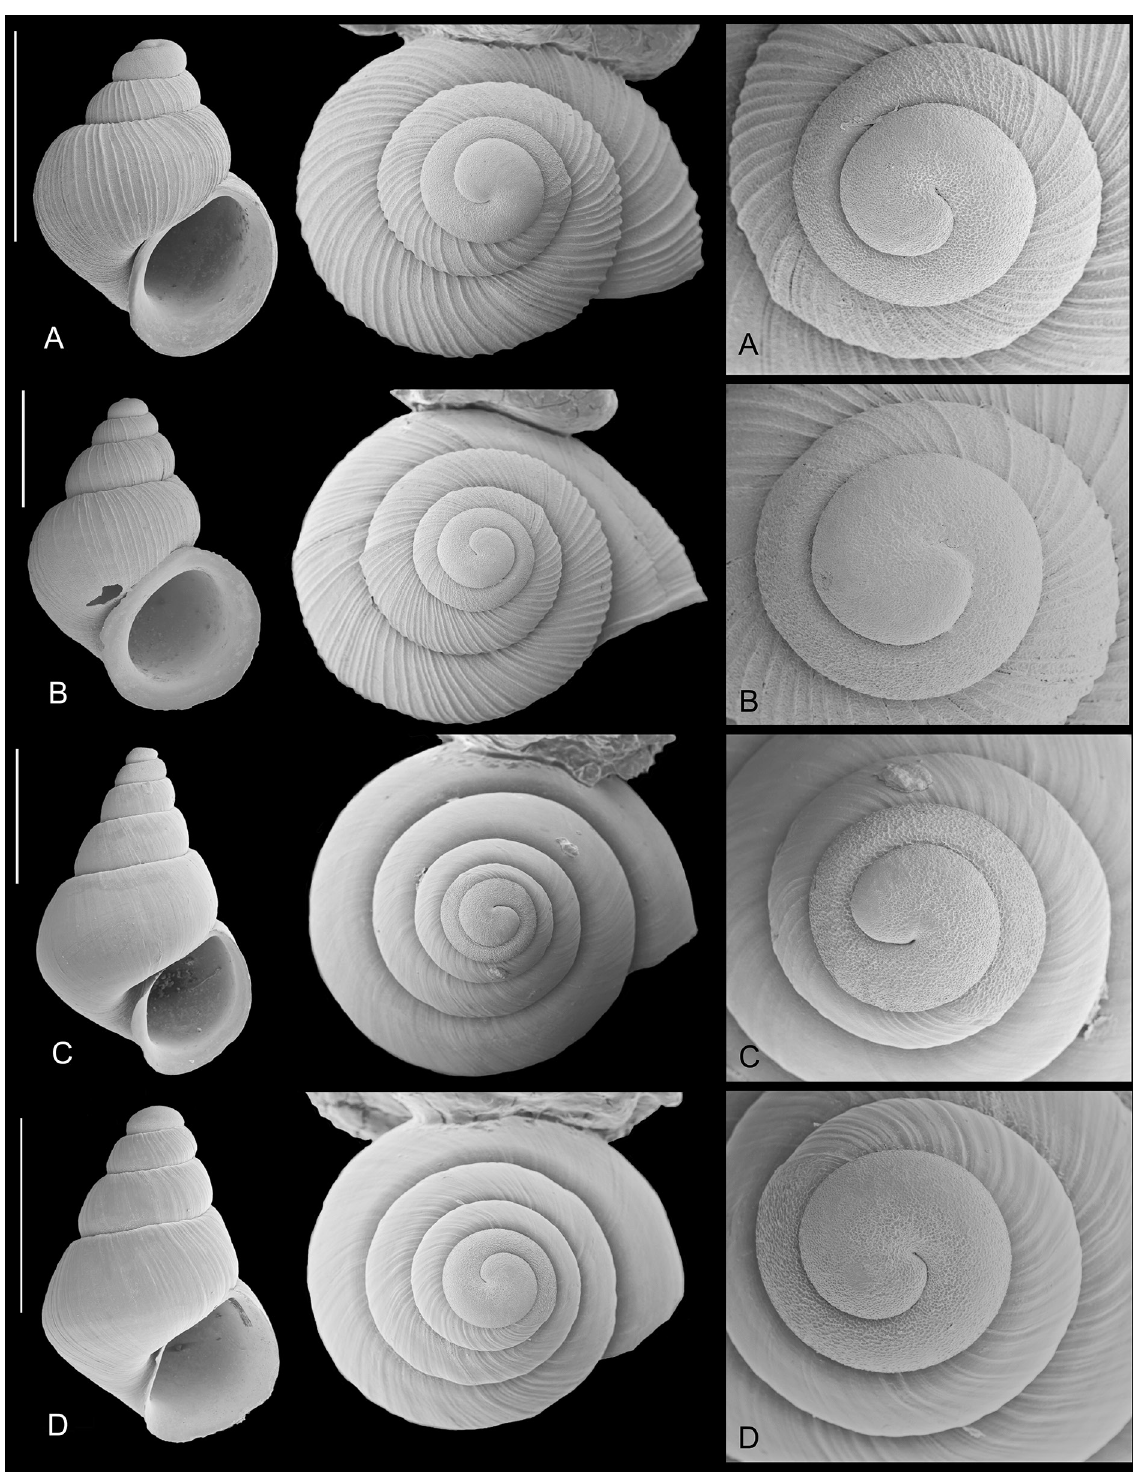
Fig. 16. A – B . Travunijana klemmi (Schütt, 1961), Croatia, spring in Stenjevac near Vrgorac. A . SMF 318873. B . Paratype SMF 164345. C . T. edlaueri (Schütt, 1961), Hercegovina, Sopot Mlin at south bank of Svitavsko Blato near Metkovic, SMF 171671. D . T. edlaueri , Hercegovina, Sjekoše at south bank of Svitavsko Blato near Metkovic, SMF 318858. Scale bars = 1 mm (SEM SMF Sigrid